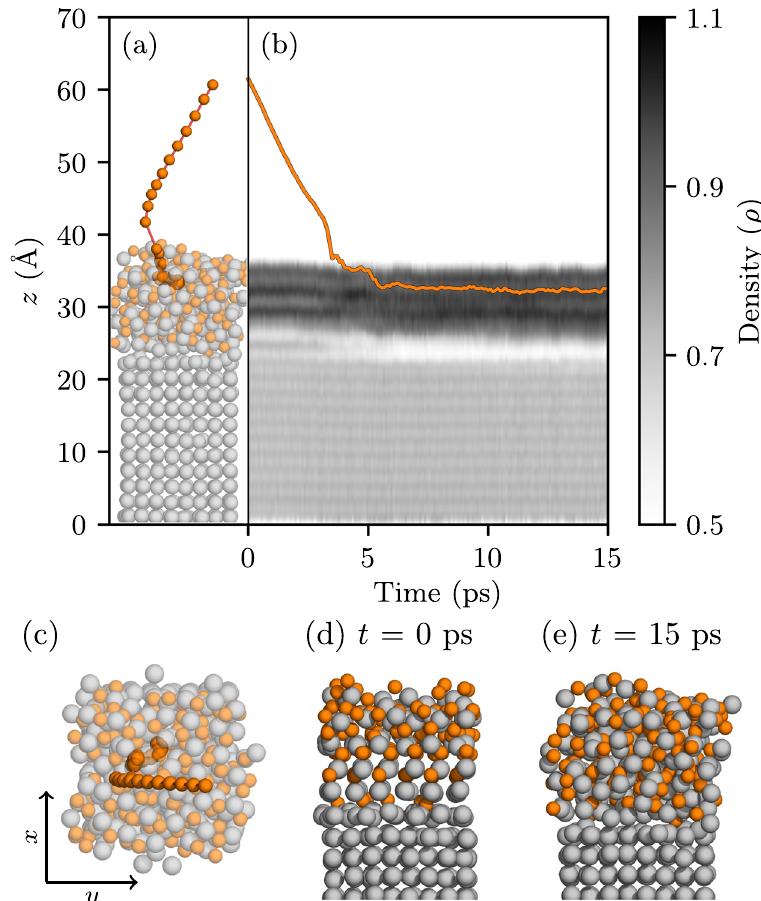
Fig. 3 Structural change in the oxide due to a deposited oxygen atom. a The path of the deposited oxygen atom is overlaid on the fi nal atomic positions for this iteration. b The density pro fi le in the structure over the duration of the simulation. The position of the deposited oxygen atom is shown as an orange line. c The path of the oxygen atom from a perspective above the structure. d The structure at the beginning of this simulation at t = 0 ps. e The structure at the end of this simulation at t = 15 ps. This calculation was performed with the S – M